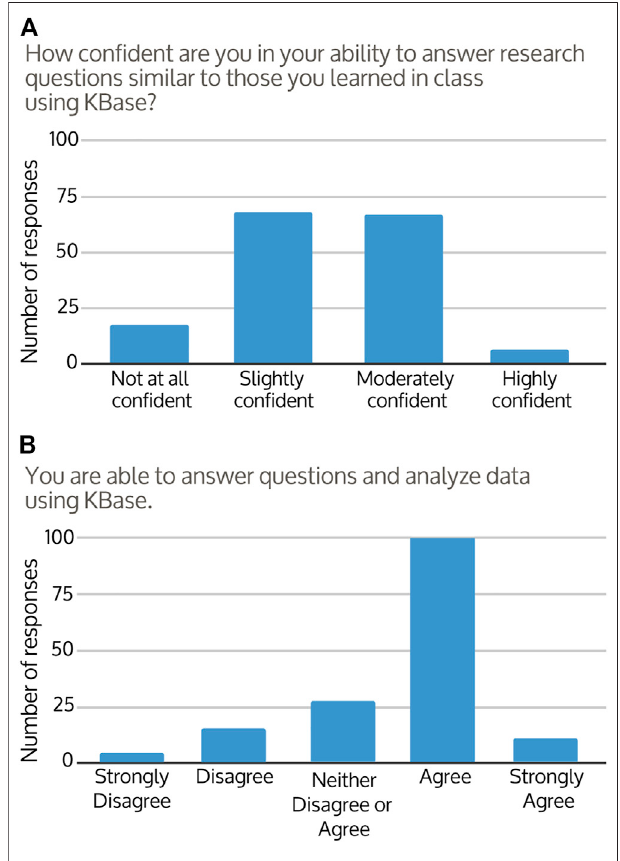
FIGURE 4 | Frequency distributions of 156 student responses to their (A) con fi dence and (B) ability to use KBase